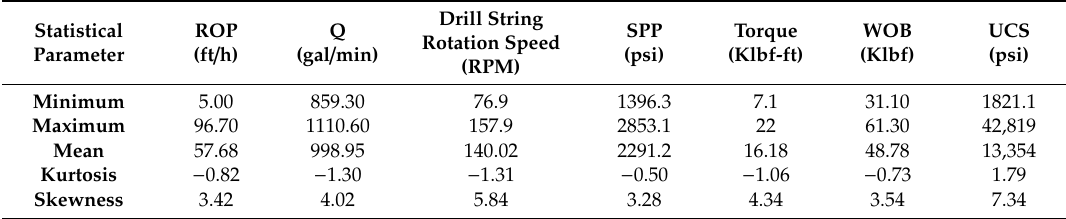
Table 1. Statistical parameters of the drilling parameters collected from the 16” intermediate section of Well A.